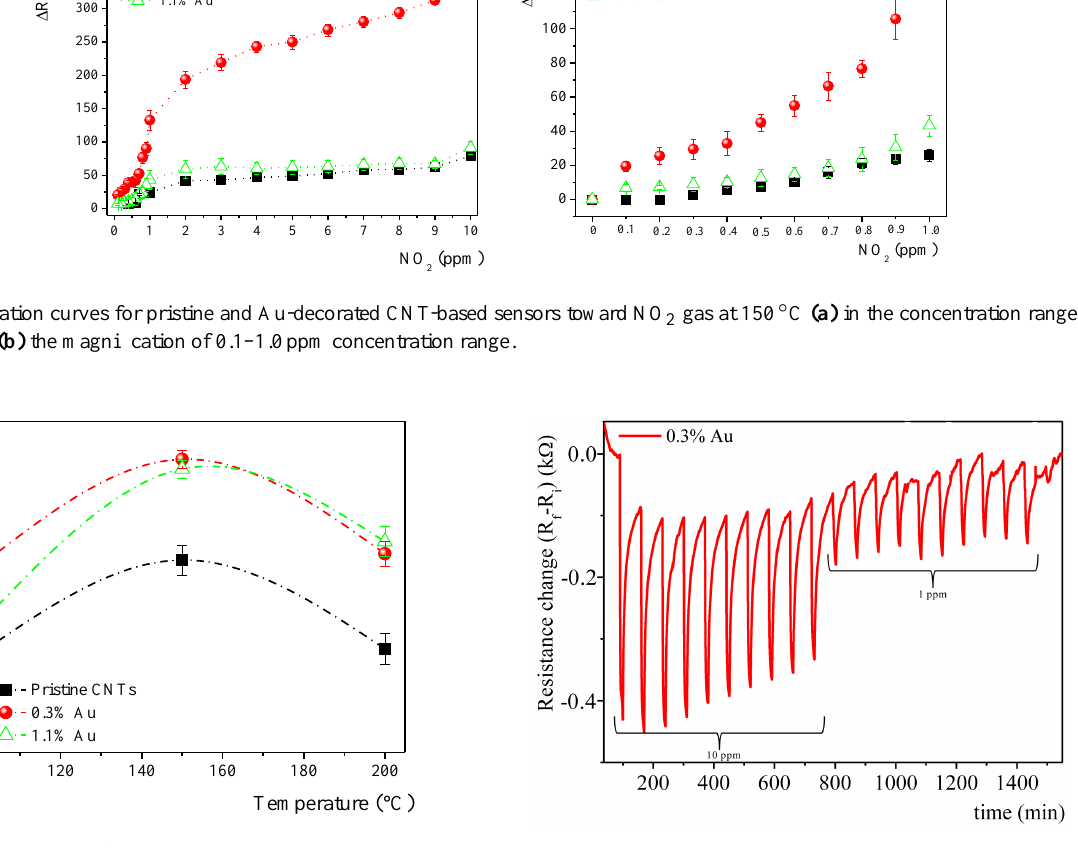
Figure 7. Mean sensitivity of pristine and Au-decorated CNT-based sensors toward NO 2 gas at different sensor operating temperatures in the range 100–200 ◦ C.